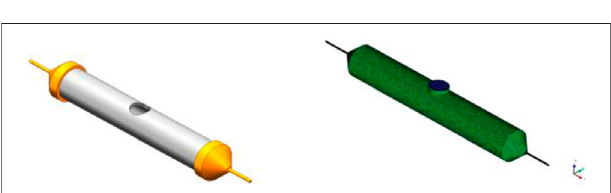
Frontiers in Bioengineering and Biotechnology |